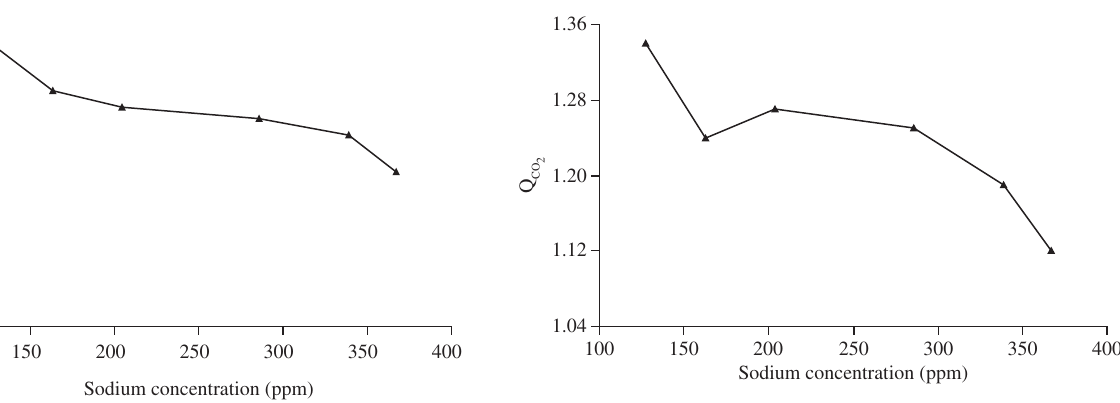
Figure 2. RRAir (%) changes as a function of the sodium concentration (ppm).